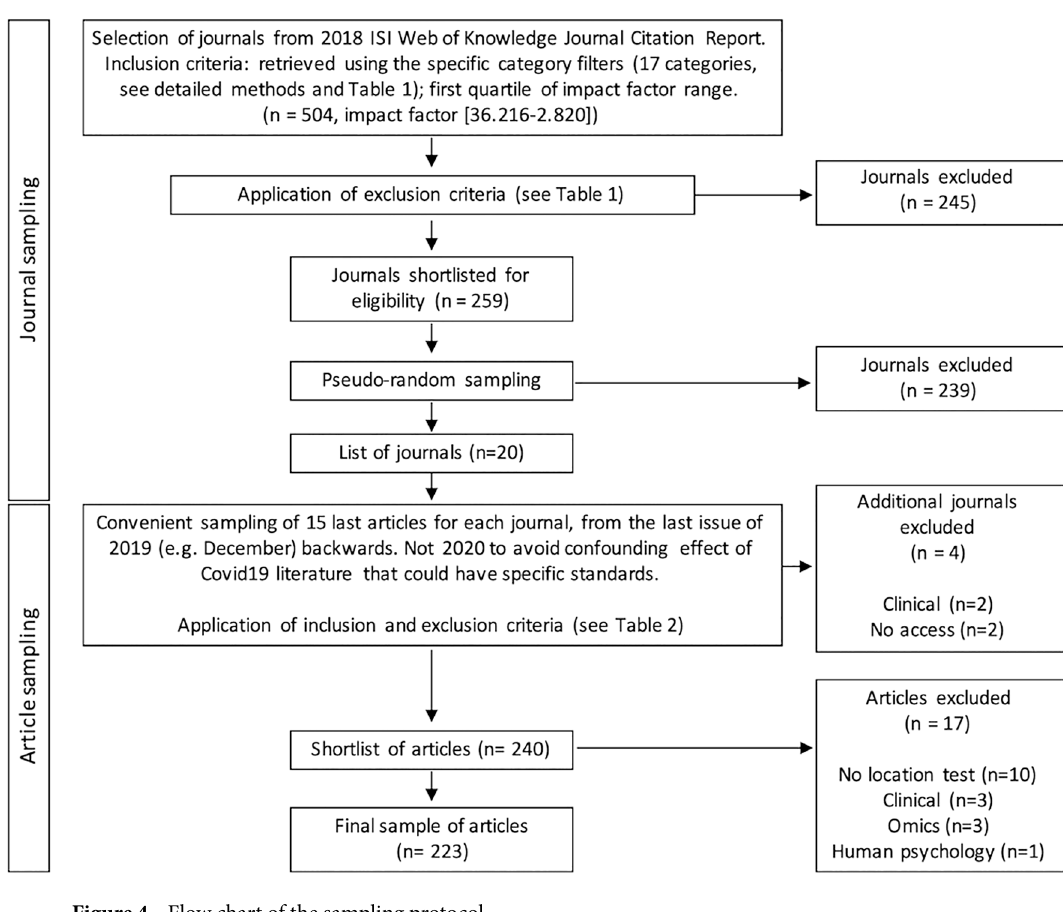
Figure 4. Flow chart of the sampling protocol.